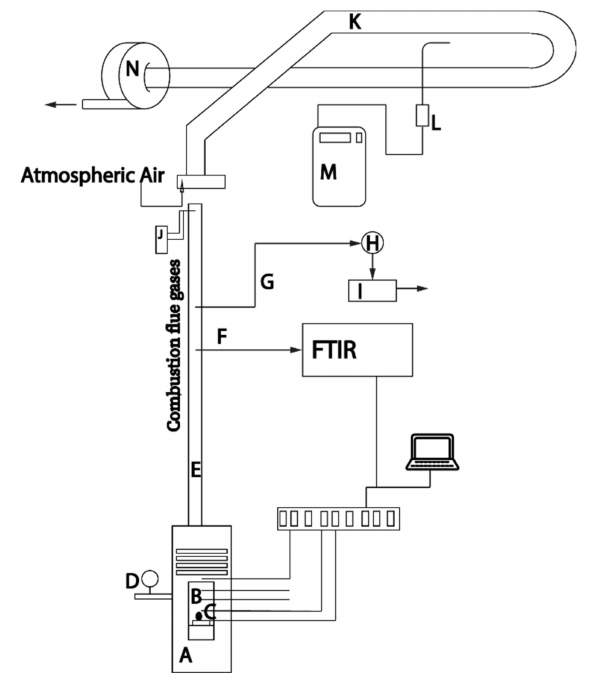
Figure 1. Installation scheme: modified from [42]. A—stove; B—combustion chamber;